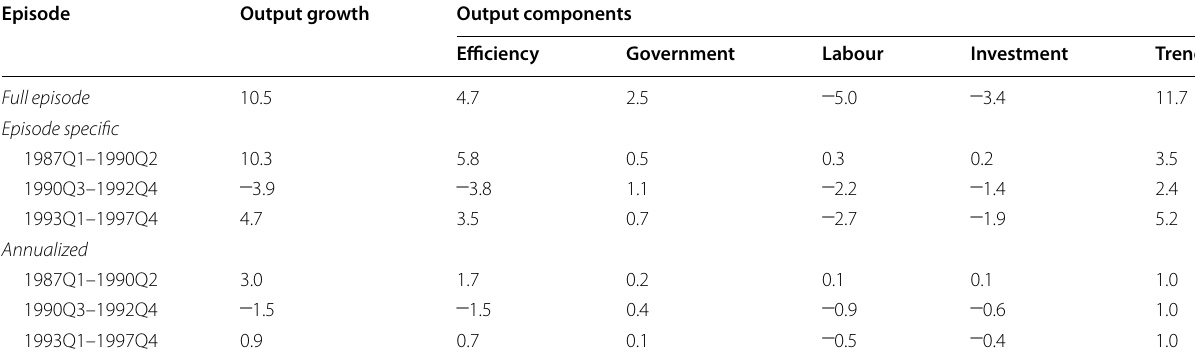
Table 10 Robustness: Decomposition of real output movements for ν = 2